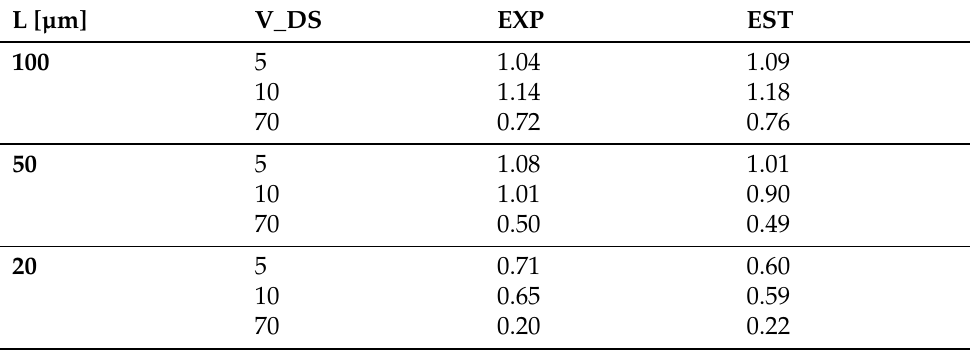
Table 2. Comparison between experimental and estimated data for CEA1298